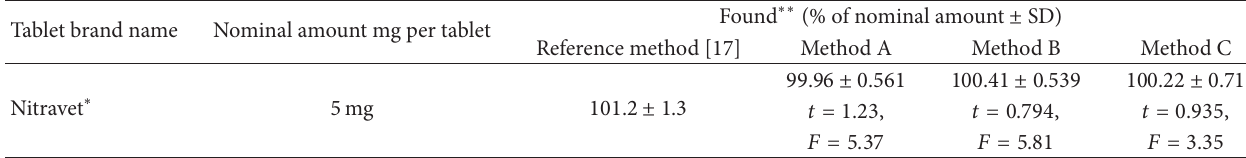
T 4: Results of determination of NTZ in tablets and statistical comparison with the reference